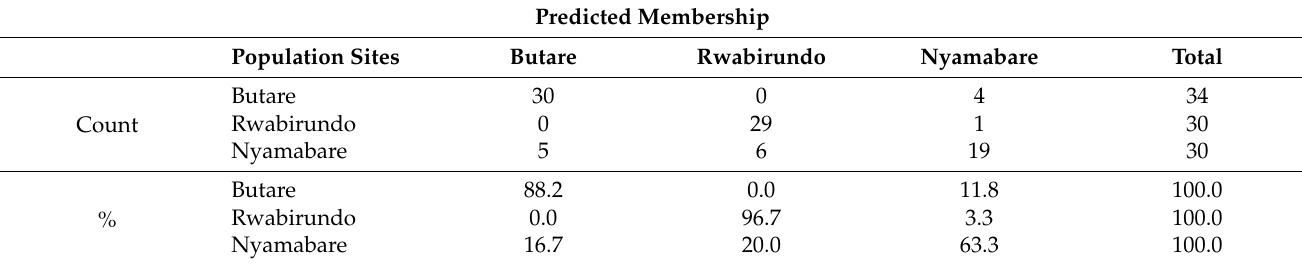
Table 5. Classification Results for Kabale sub